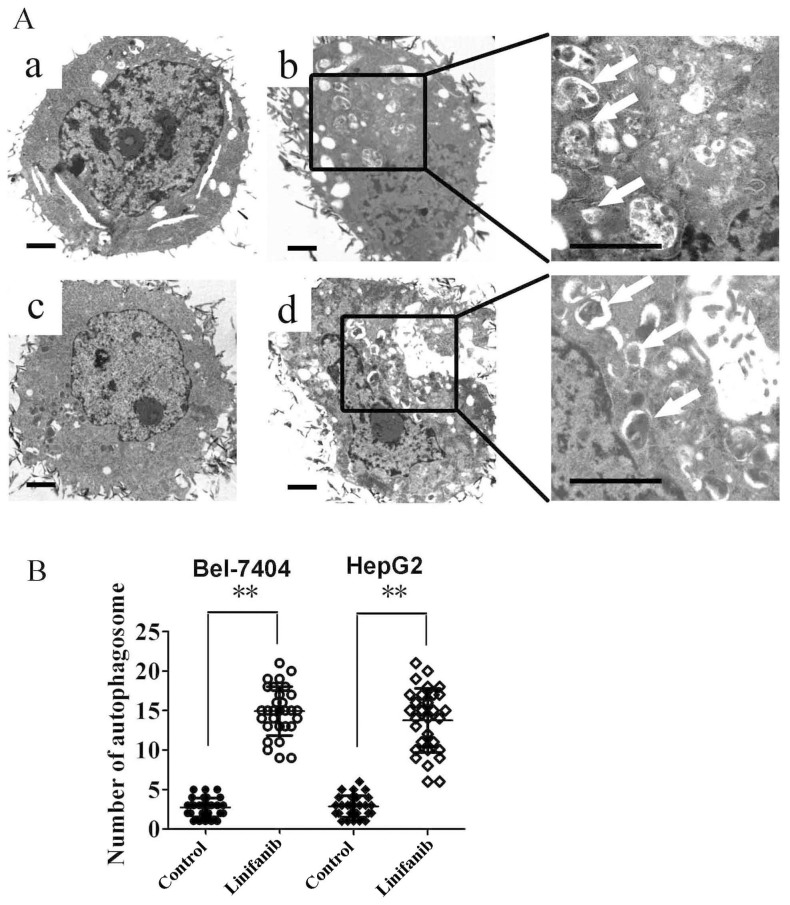
TEM depicting ultrastructures of autophagosome in cells treated with linifanib.(A). Numerous typical double-layer membrane autophagosomes (arrows) appeared in Bel-7404 and HepG2 cells treated with 2.5 μM linifanib for 24 hours. (a: Bel-7404, DMSO; b: Bel-7404, linifanib; c: HepG2, DMSO; d: HepG2, linifanib). (B). The number of autophagosomes was calculated by continuous counts in 10 fields under high resolution. Bar = 1 μm. ** P < 0.01.